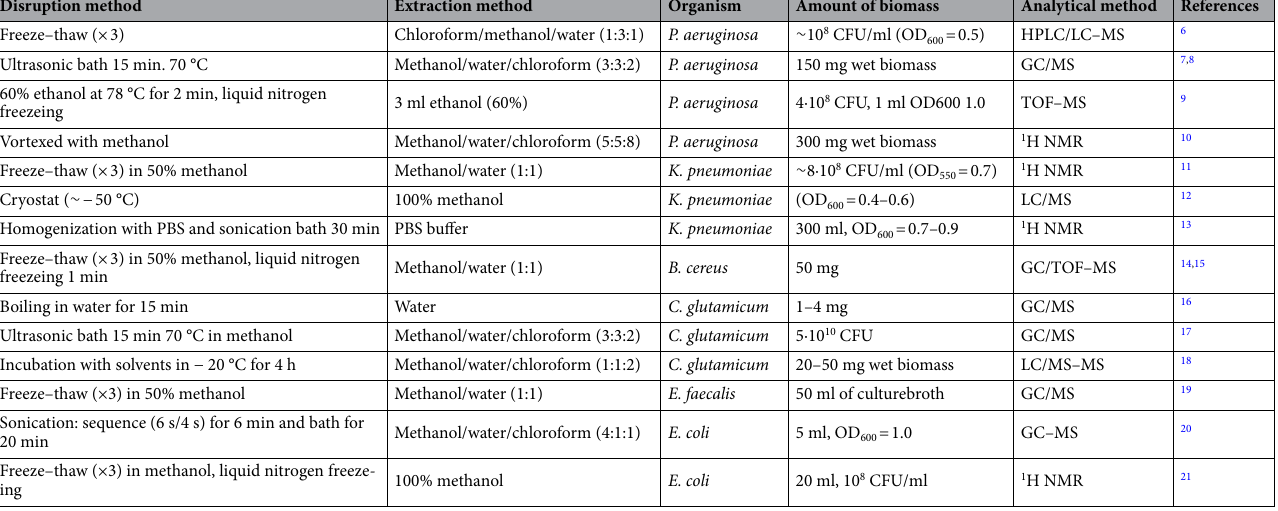
Table 1. Cell disruption methods used in metabolome